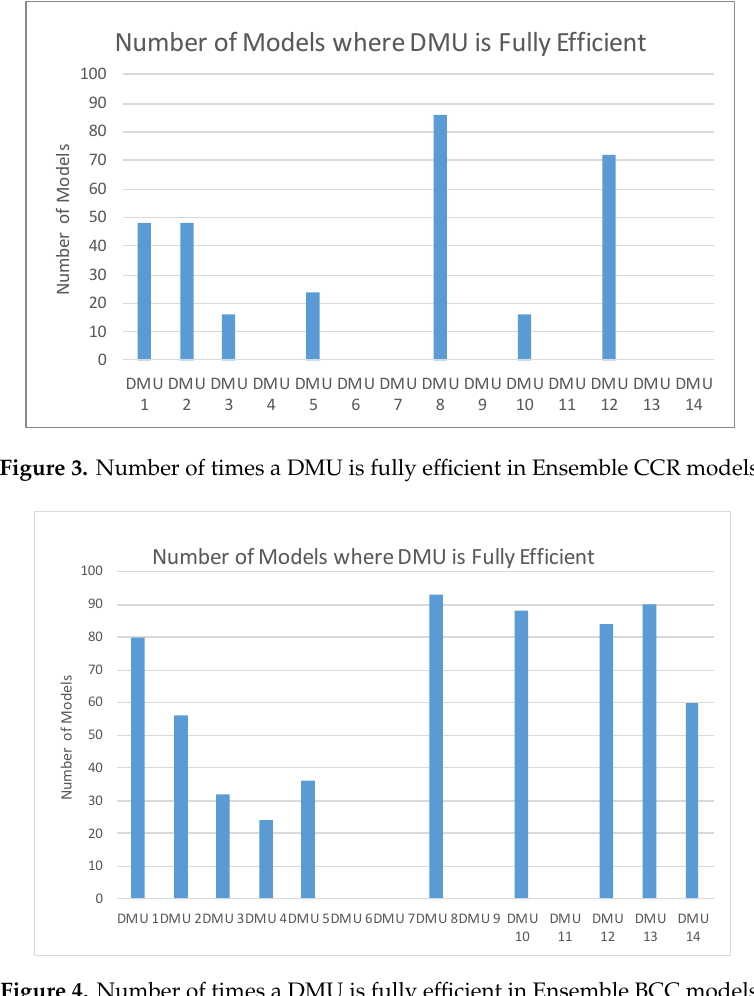
Figure 4. Number of times a DMU is fully efficient in Ensemble BCC models.